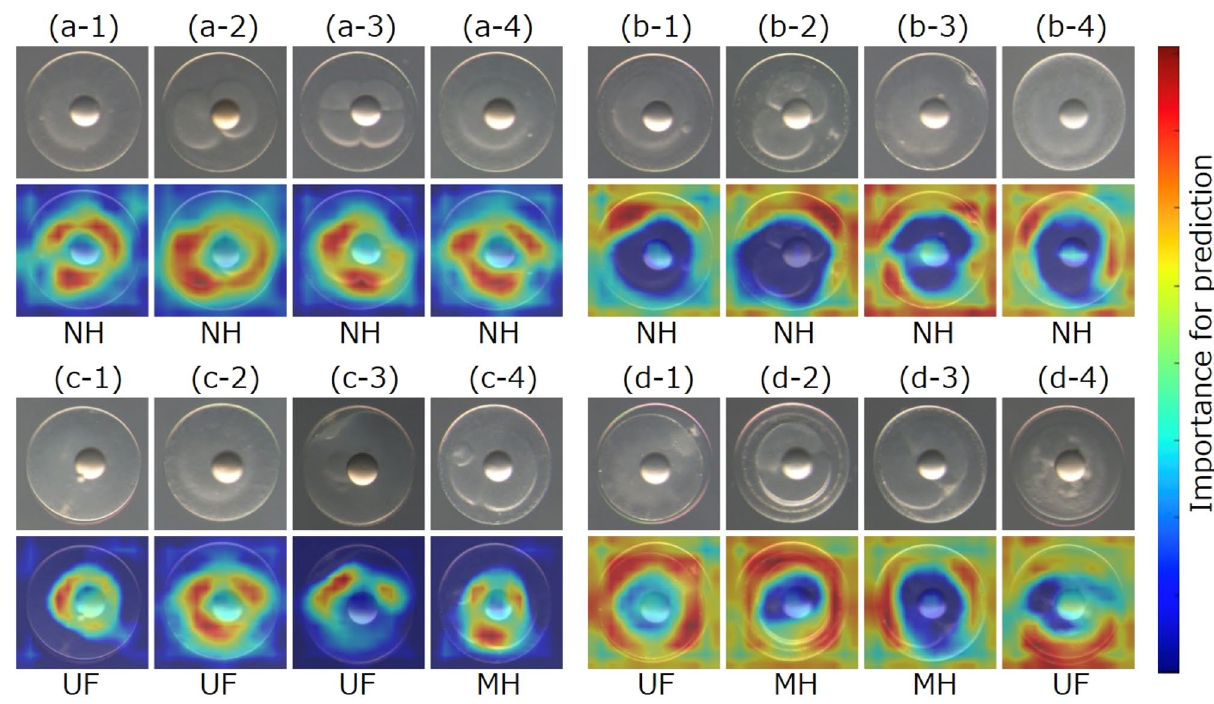
Figure 5. Examples of visualized image aspects that contributed to NH prediction. The images in the first and third rows are the input contour images; those in the second and bottom rows show the parts of the eggs that contributed to the prediction as visualized by Grad-CAM. Images ( a ) and ( c ) were predicted as NH; ( b ) and ( d ) were predicted as not NH. Each acronym below the visualized images indicates the hatching status. That is, examples of true-positive ( a ), false-negative ( b ), false-positive ( c ), and true-negative ( d ),